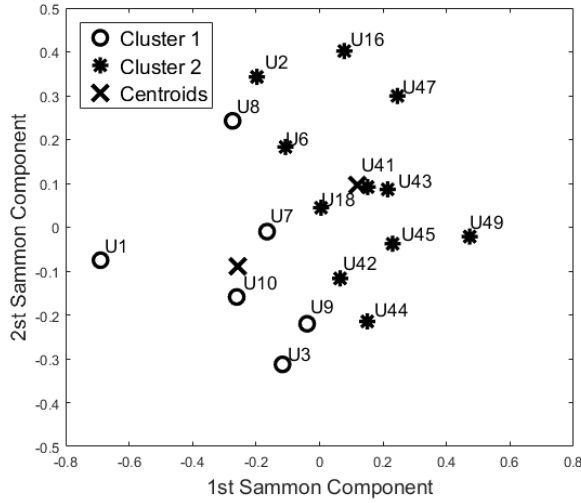
Figure 8. Cluster analysis of Lounge Activity (K-Means and Self-Organizing Maps).